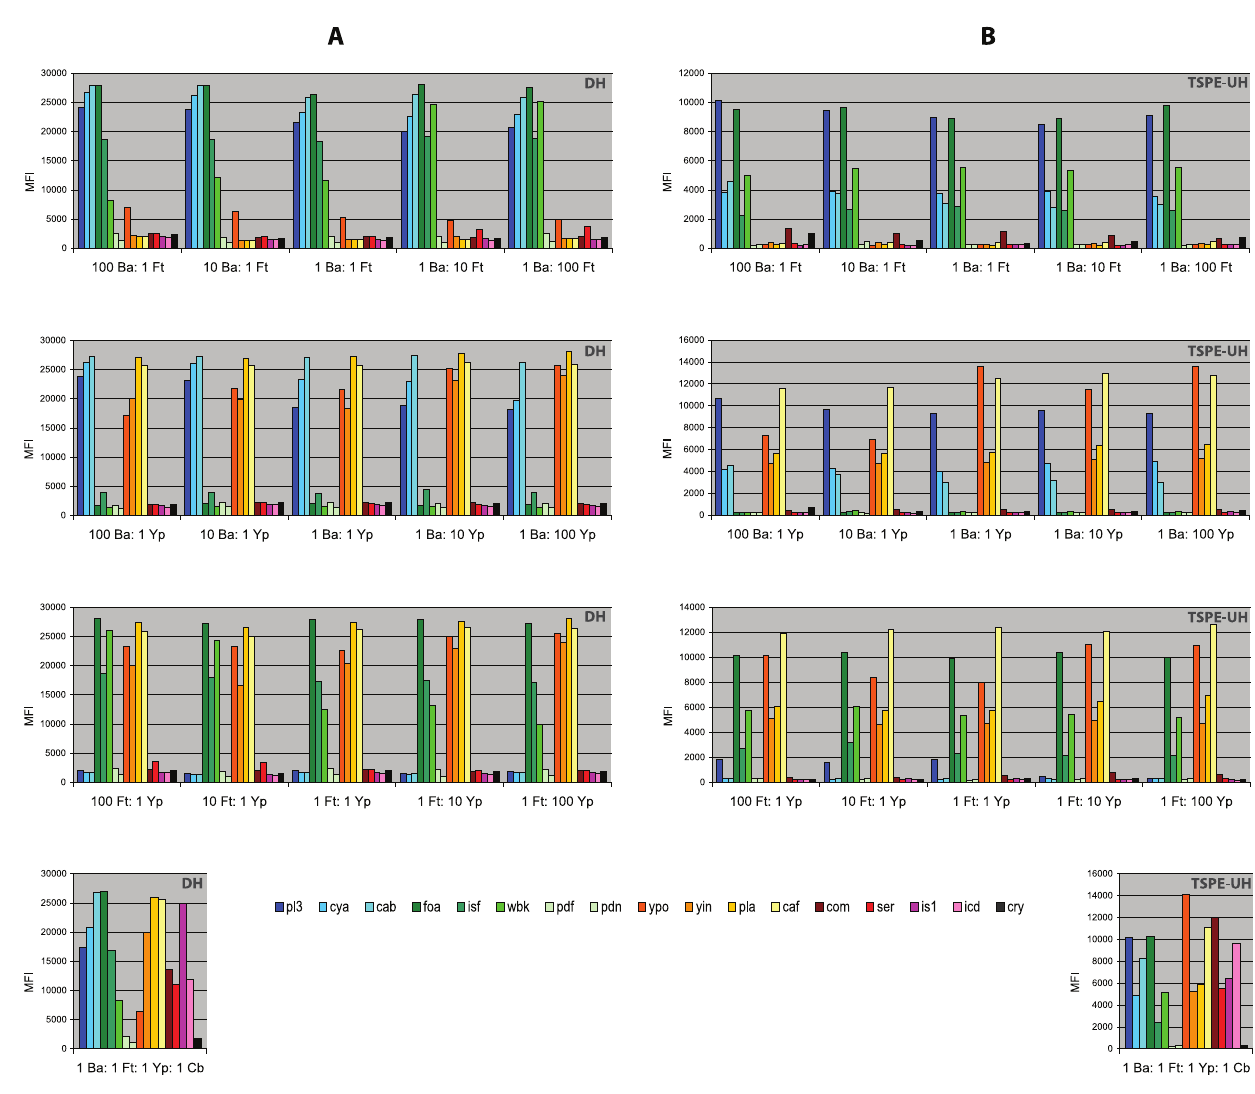
Figure 3. Detection of mixed pathogens by using DH and TSPE-UH suspension microarrays. Genomic DNA from B. anthracis (Ba), F. tularensis (Ft), Y. pestis (Yp), C. burnetii (Cb) was mixed in different ratios and measured by using DH ( A ) and TSPE-UH ( B ) microarrays. Mean fluorescence intensity (MFI) is displayed for the different pathogen-specific probes (Table 1). The detection of one pathogen is not impeded by the detection of the other targeted pathogens.